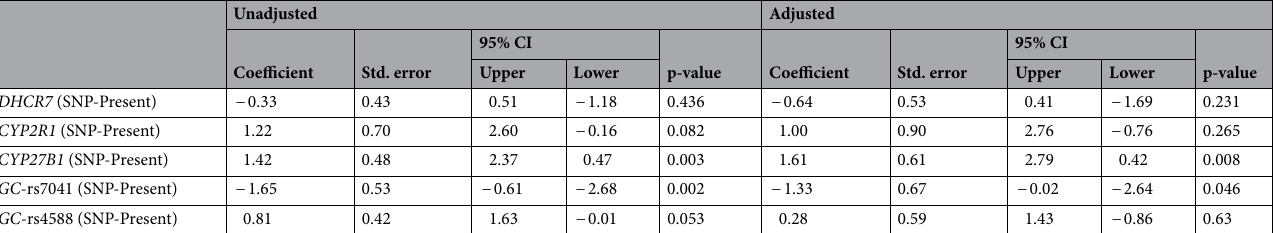
Table 4. Association of SNPs to vitamin D deficiency among 12–24-month-old children living in an urban and rural Bangladesh (Ref. Wild type).